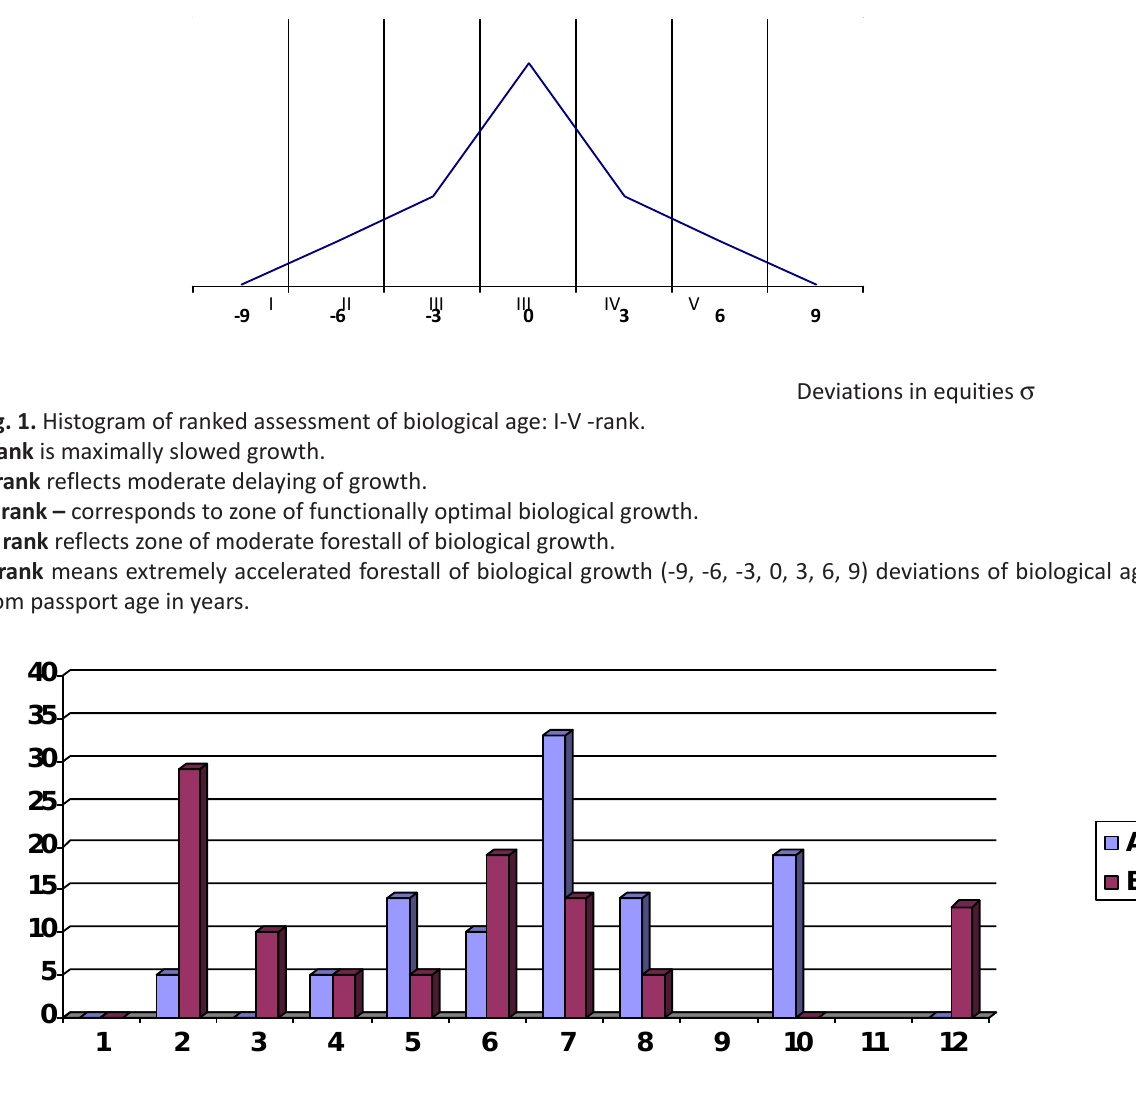
Fig. 2. Sitting hours in working day and day off: A – working day; B – day off; t – time in hours; on X-axis – percents from the number of participants.